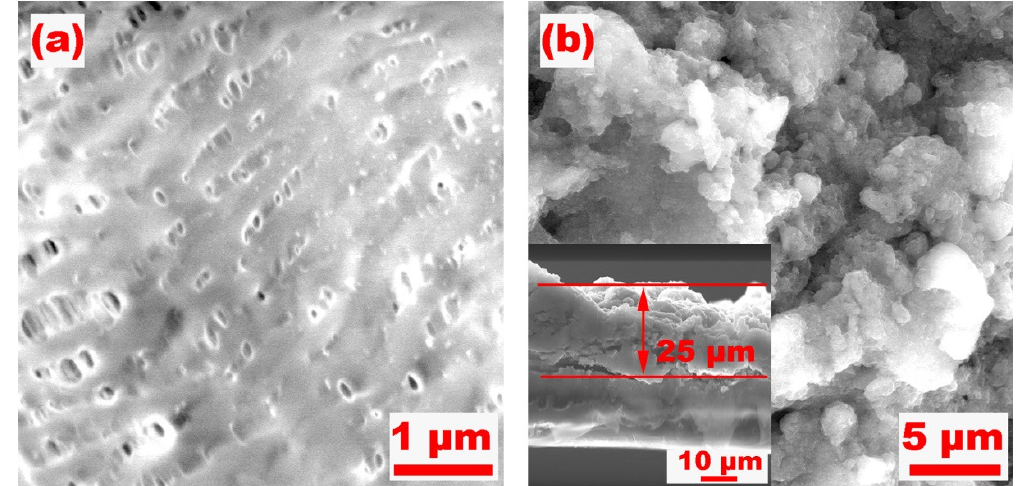
Figure 4. Top-view SEM images of the ( a ) Conventional separator and the ( b ) ZnO/NDG composite-coated separator. The inset in ( b ) shows the cross-sectional view of the modified separator.